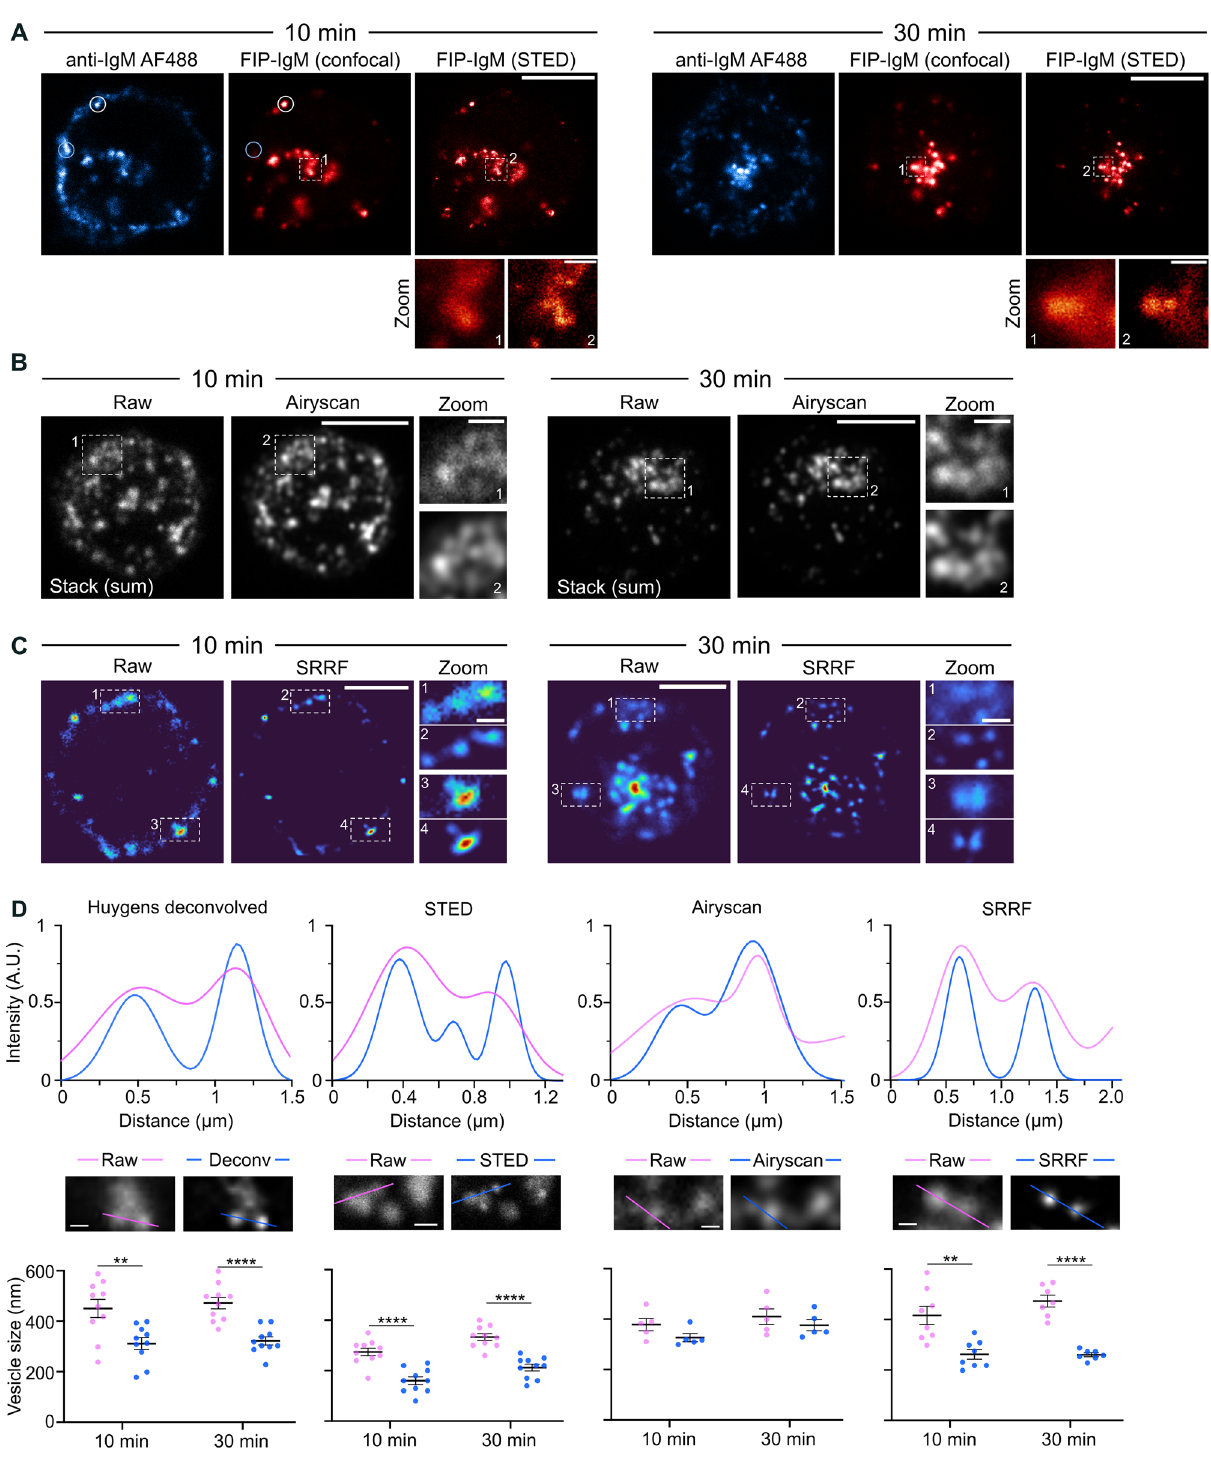
Figure 6. Super-resolution imaging of internalised BCR-antigen complexes using the SHIP assay ( A ) B cells were activated with Abberior-FIP-IgM and AF488 anti-IgM for 10 and 30 min, quenched with BHQ3-QP, fixed and imaged with Abberior STED. A representative image (1 slice) of each channel is shown. The white circle shows one example of an internalized vesicle, and the blue circle marks an example of non-internalised antigen. The dashed rectangle is shown as a zoom inset. Scale bar: 5 µm; scale bar of the inset: 500 nm. LUTs: Hot Cyan and NanoJ-Orange. ( B ) B cells were activated with ATTO-FIP-IgM for 10 and 30 min, quenched with BHQ3-QP, fixed and imaged with Airyscan. A representative stack image (sum intensity projection) is shown. The dashed rectangle is shown as a zoom inset. Scale bar: 5 µm; scale bar of the inset: 1 µm. ( C ) B cells were activated with ATTO-FIP-IgM for 10 and 30 min and imaged with SDCM. A total of 100 frames per image were acquired to perform SRRF. A representative image (once slice) is shown. Scale bar: 5 µm; scale bar of the inset: 1 µm. ( D ) Representative profile plots (upper row) comparing the apparent vesicle size of the different imaging techniques. The images (middle row) show the image regions and the line scan position used for the profile plots and the plots (bottom row) with the FWHM of the curves before (pink) and after (blue) super-resolution. ** P < 0.01, **** P < 0.001; paired t-test (n =